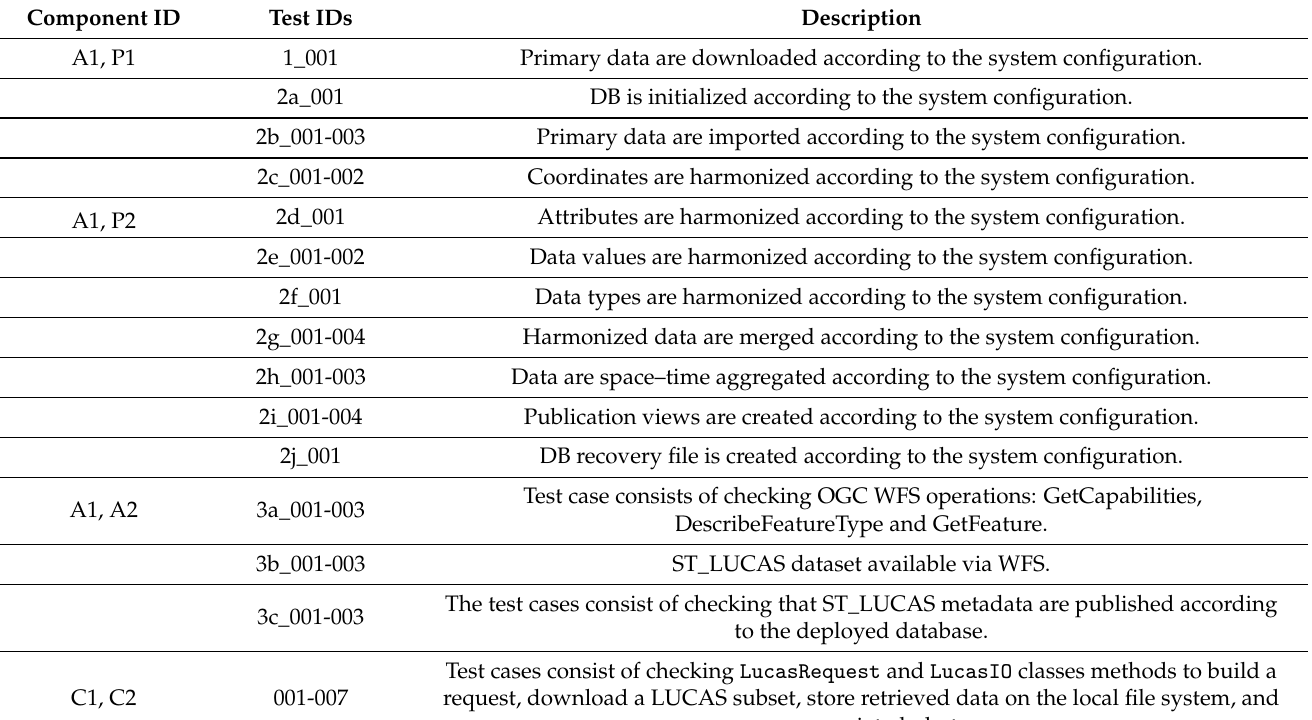
Table 2. Overview of unit tests. Test IDs reflect the system dynamic architecture as presented in Figure 5.